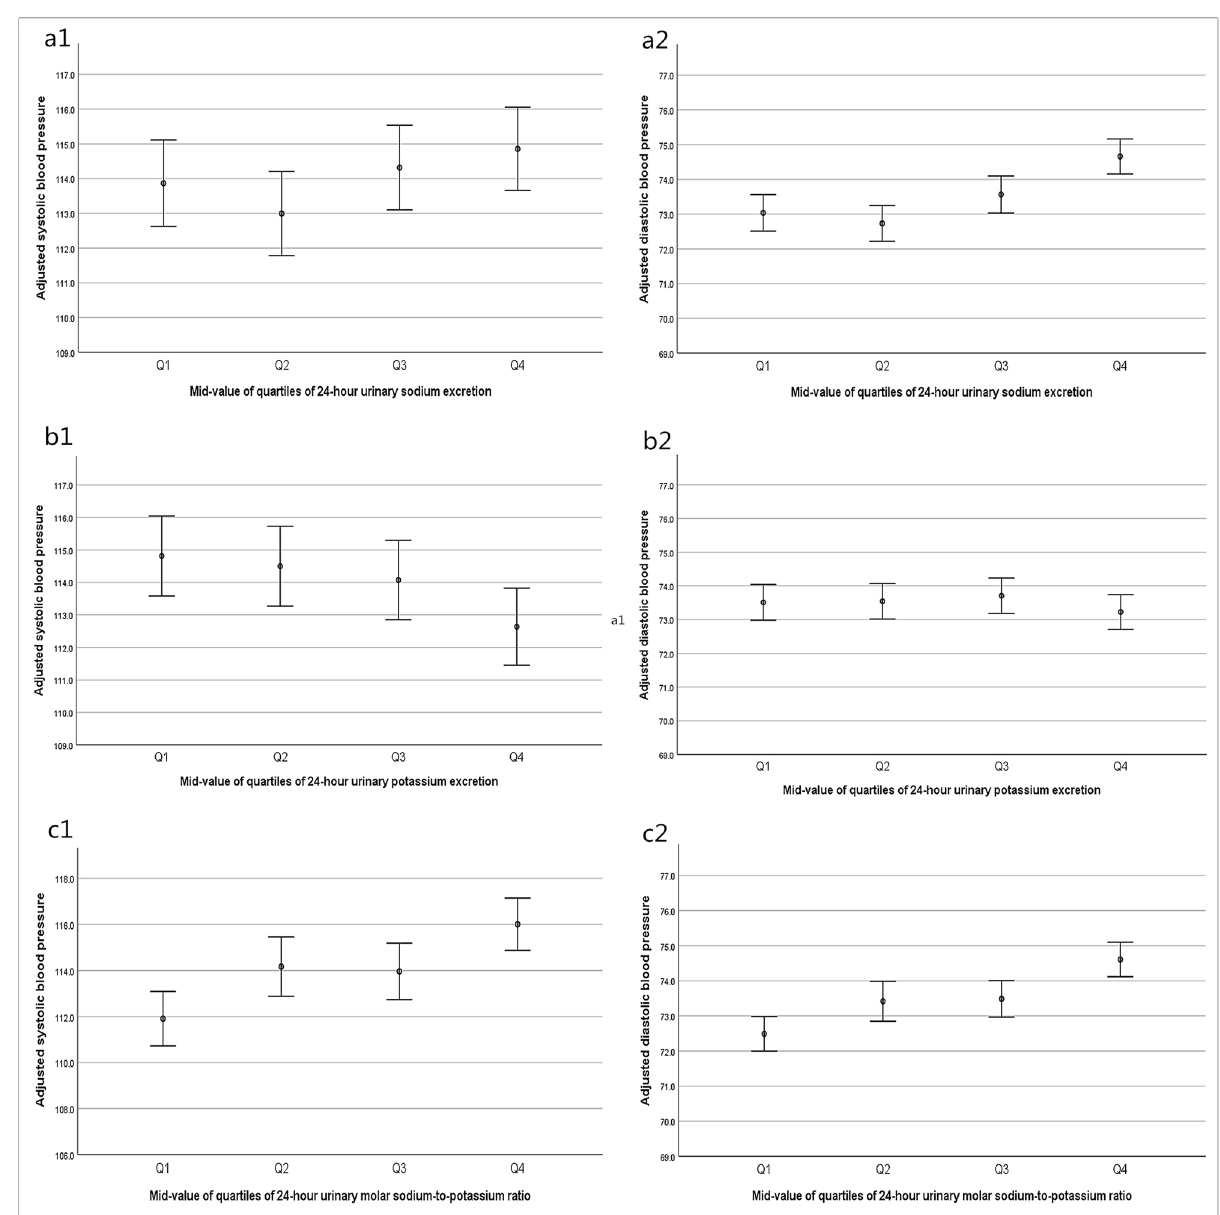
Figure 1. Adjusted SBP and DBP at the mid-quartile of 24-h urinary sodium and potassium excretion and their ratio. This figure presents adjusted SBP at the 12.5th, 37.5th, 62.5th, and 87.5th percentiles of sodium excretion ( a1 ), potassium excretion ( b1 ), and the sodium-to-potassium ratio ( c1 ). Simultaneously, the results related to DBP are shown in ( a2 ), ( b2 ), and ( c2